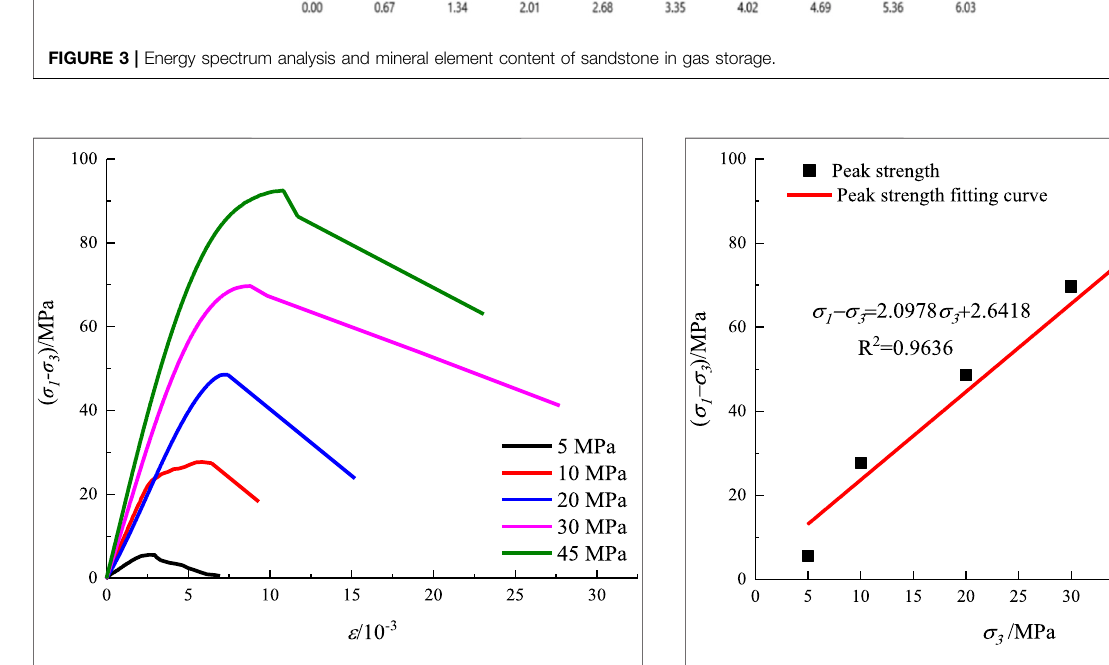
FIGURE 4 | The conventional triaxial compression stress-strain curve of sandstone.